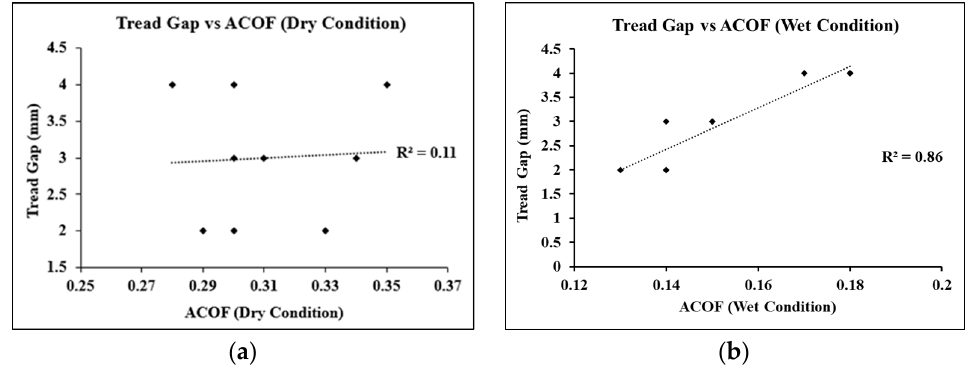
Figure 11. Effect of tread gap on ACOF: ( a ) in dry condition and ( b ) in wet condition.